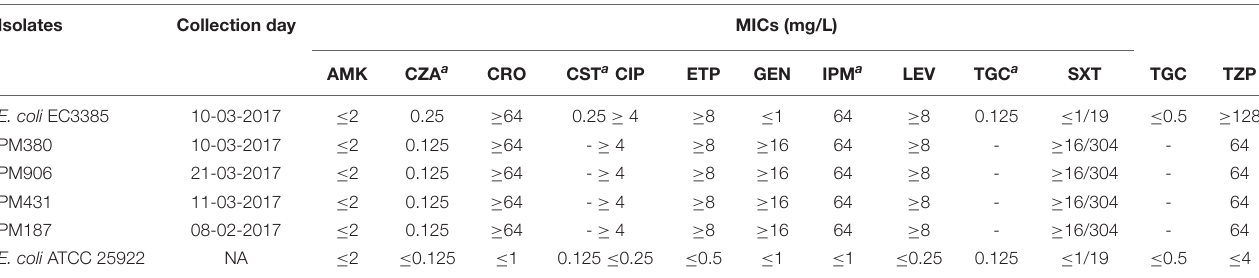
TABLE 1 | Strains collection date and Vitek-2 antibiotic susceptibility.